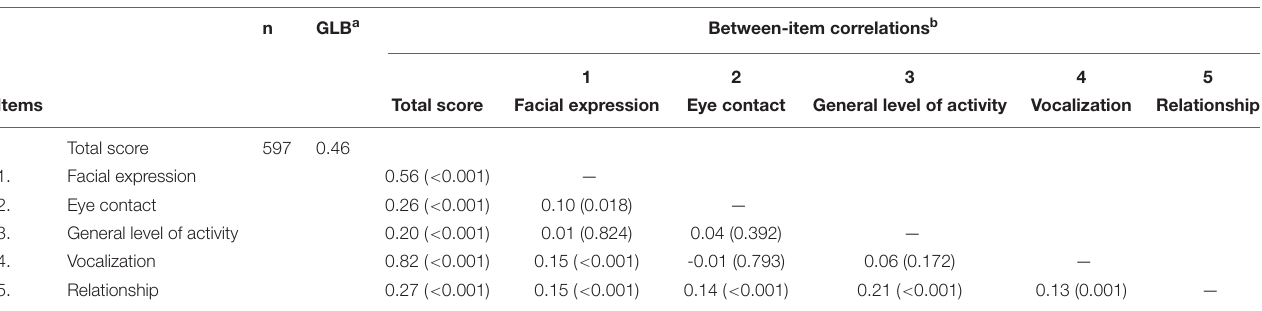
TABLE 5 | Internal consistency of the modified Alarm Distress Baby Scale in 597 Nepalese